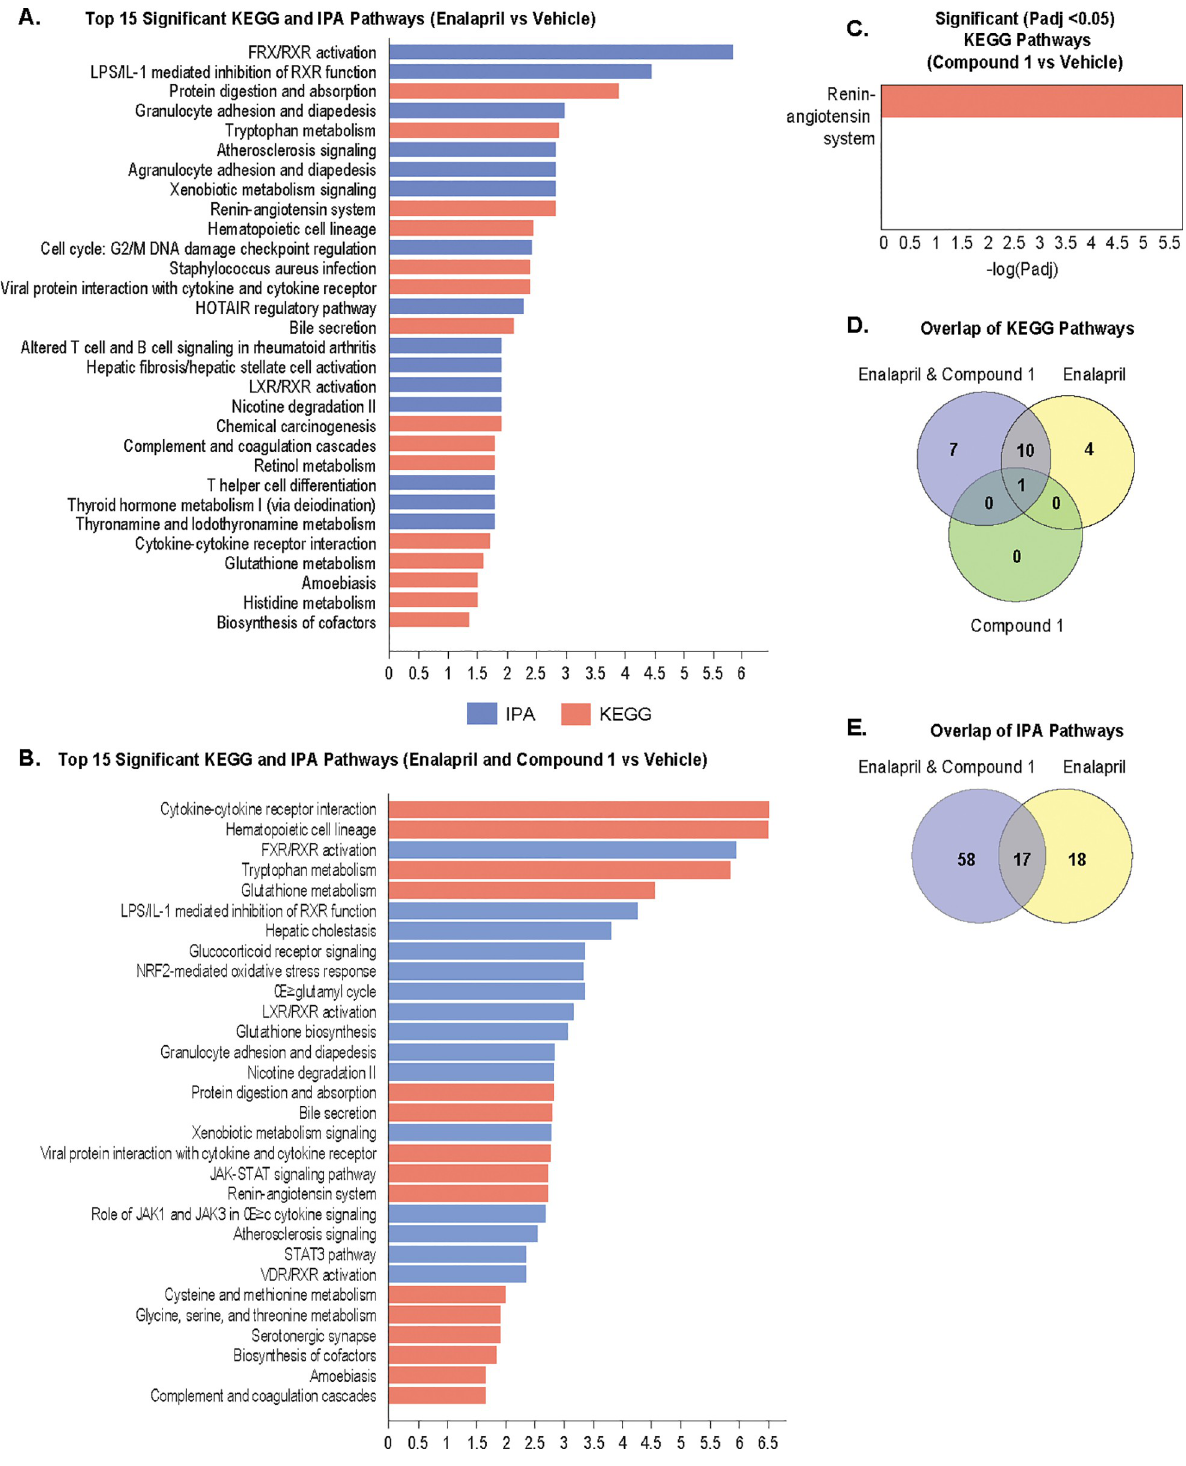
Fig 10. Significantly enriched pathways. (A) Top 15 significant pathways of both KEGG and IPA from Enalapril vs Vehicle. (B) Top 15 significant pathways of both KEGG and IPA from Enalapril and Compound 1 vs Vehicle. (C) Significant ( P adj < 0.05) KEGG pathways from Compound 1 vs Vehicle. (D) Venn diagram of significantly enriched KEGG pathways ( P adj < 0.05) from 3 treatments. (E) Venn diagram of significantly enriched IPA pathways ( P adj < 0.05) from Enalapril and Compound 1 vs Vehicle and Compound 1 vs Vehicle.